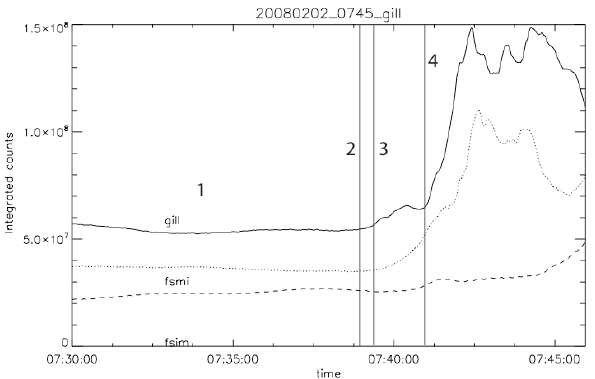
Fig. 6. Total light curves seen by the all sky imagers at Gillam Fort Smith and Fort Simpson. The various ground based onset events are shown with numerals 1 to 4, where 1 is the pre-onset fading of the arc as seen by the dip in intensity, 2 is the time when the equa- torward arc starts intensifying, 3 is the appearance of a new rayed arc feature and 4 is the onset of the Substorm Poleward Expansion (SPE) and rapid intensification of the aurora associated with the